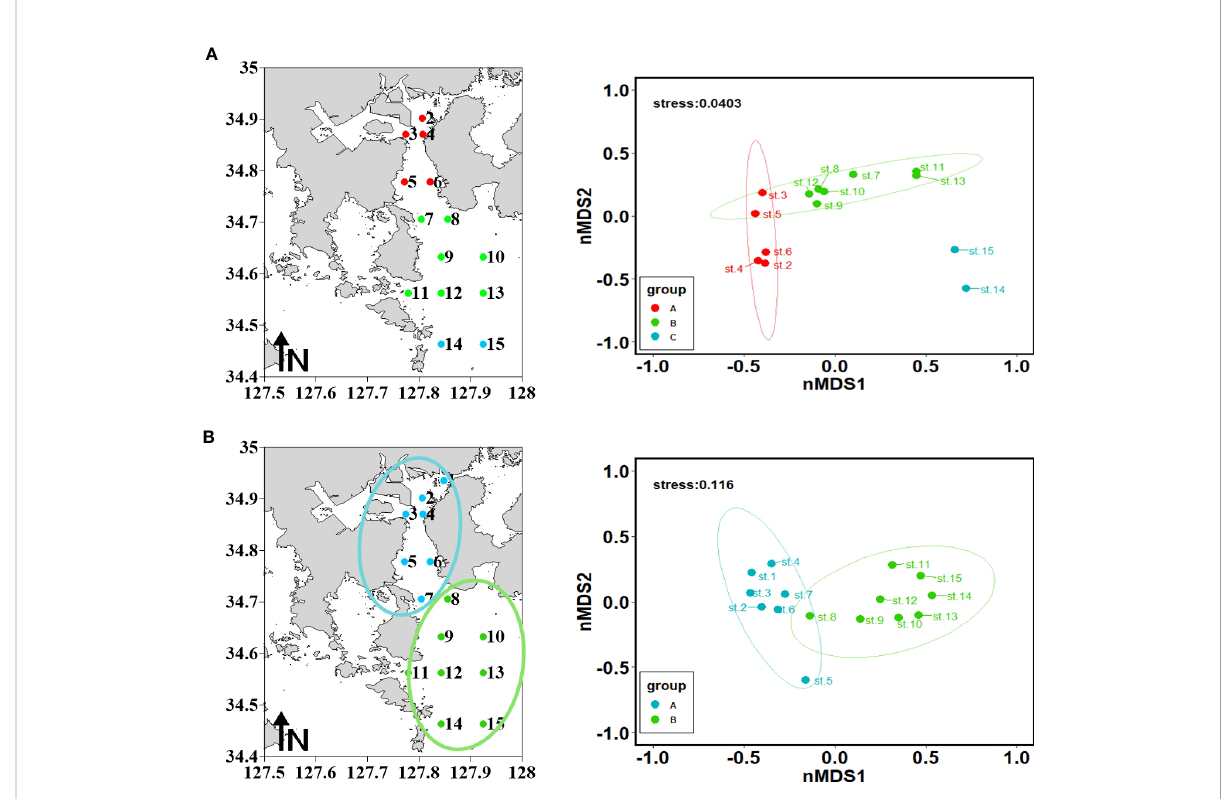
FIGURE 5 Results of Bray – Curtis dissimilarities – based cluster analysis and non-metric multidimensional scaling (nMDS) ordination plots for June (A) and August (B)